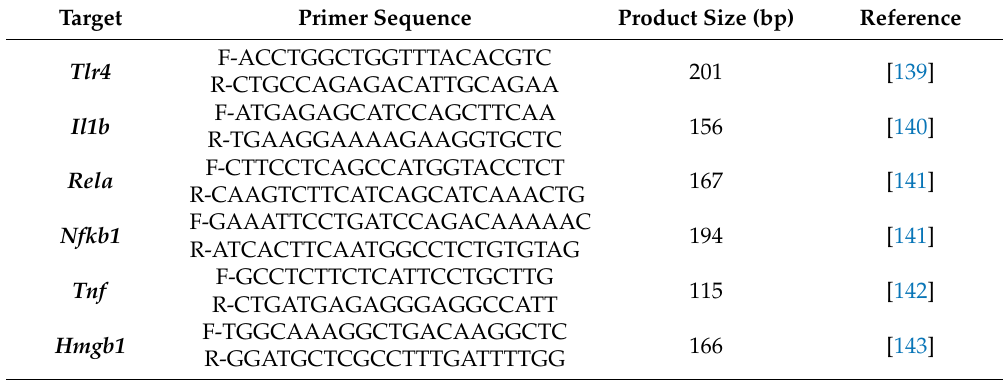
Table A2. Primer pair sequences of mRNA transcripts in mouse tissue.